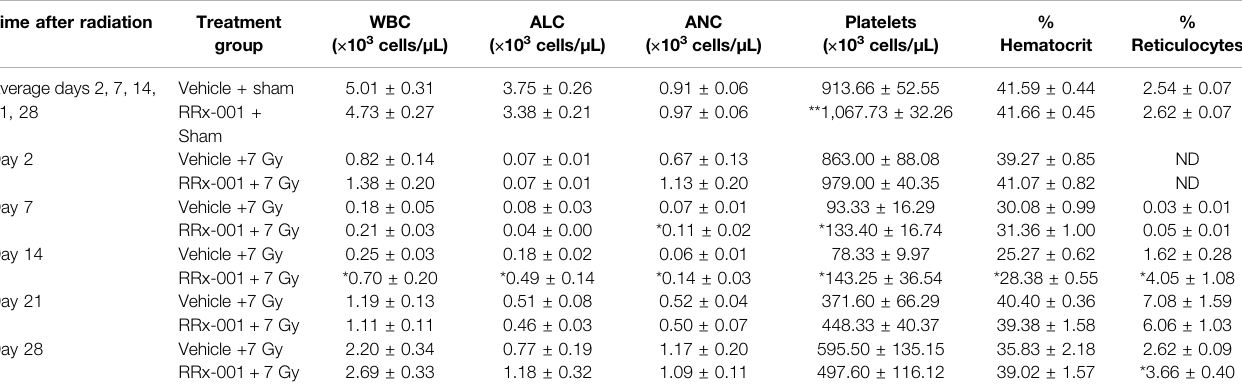
Valuesarethe mean ± SEM( n (cid:1) 2 – 3 mice/group/time point);ND,notdetermined.* p < 0.05 comparingtheirradiated groups/timepoint.Signi fi cancewas determinedusinga parametric test consisting of a general linear model ANOVA and the Kruskal – Wallis nonparametric test. ** p < 0.01 comparing the nonirradiated groups combining days 2, 7, 14, 21 and 28. Signi fi cance was determined using the longitudinal mixed model repeated measures analysis. This experiment was performed in duplicate.